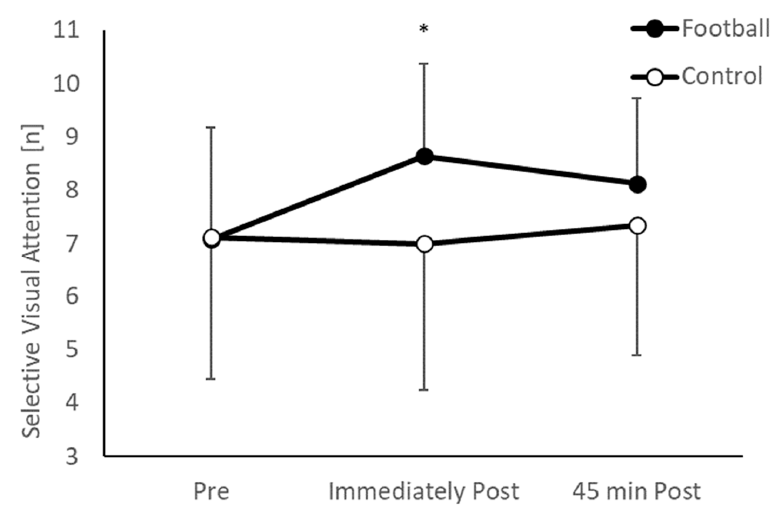
Figure 1. Selective visual attention ([n] = number of correctly identified symbols) in the football and control groups across the morning (group * time interaction, p < 0.001; * football > control, p = 0.003).